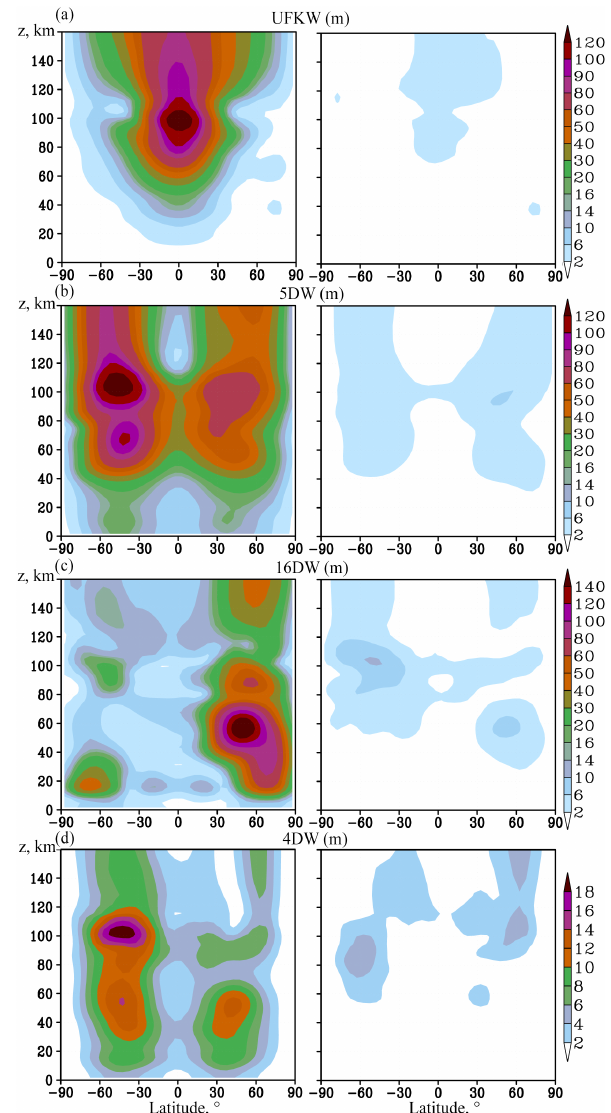
Figure 1. Amplitudes of variations of geopotential height (m) with the source of the respective PW in the MUAM being turned on (left panels) and off (right panels) for the following PW modes: (a) ultra- fast Kelvin wave, (b) 5d PW, (c) 16d (all with a zonal wave number m = 1) and (d) 4d PW (with m = 2). Note that the colour scale is different for different